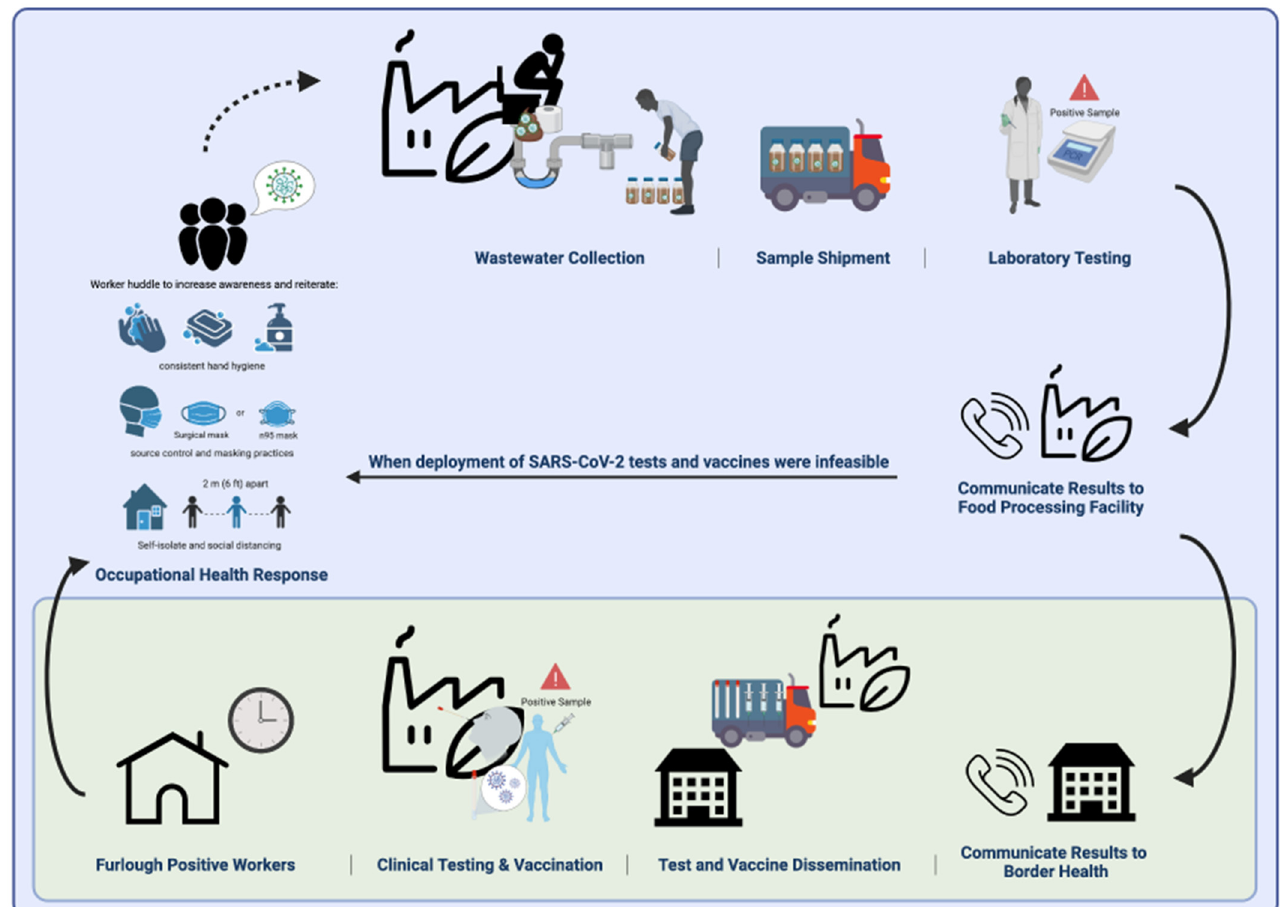
Figure 1. Wastewater Based Epidemiology Process to Monitor SARS-CoV-2 and Conduct Public Health Action an Arizona Food Processing Facility. Wastewater samples were collected biweekly from a food processing plant’s septic tank, shipped to a laboratory, processed, filtered, and analyzed for SARS-CoV-2 N1 RNA). Regardless of the feasibility to deploy SARS-CoV-2 antigen tests and vaccines, positive and negative samples were communicated with the food processing facility’s point of contact; all positive signals were communicated with food processing facility leadership and public health. Facility leadership increased awareness among staff and reiterated important infection control protocols to prevent further transmission within the facility. When deployment of tests and vaccines were feasible, results were communicated to Border Health representatives, who deployed medical products. Individuals diagnosed with SARS-CoV-2 via antigen tests were furloughed until deemed safe to return to work, in compliance with CDC guidance. Adapted from “COVID-19 Safety Information”, by BioRender.com (2022). Retrieved from https://app.biorender.com/biorender-templates. Images also provided by SVGRepo.com.